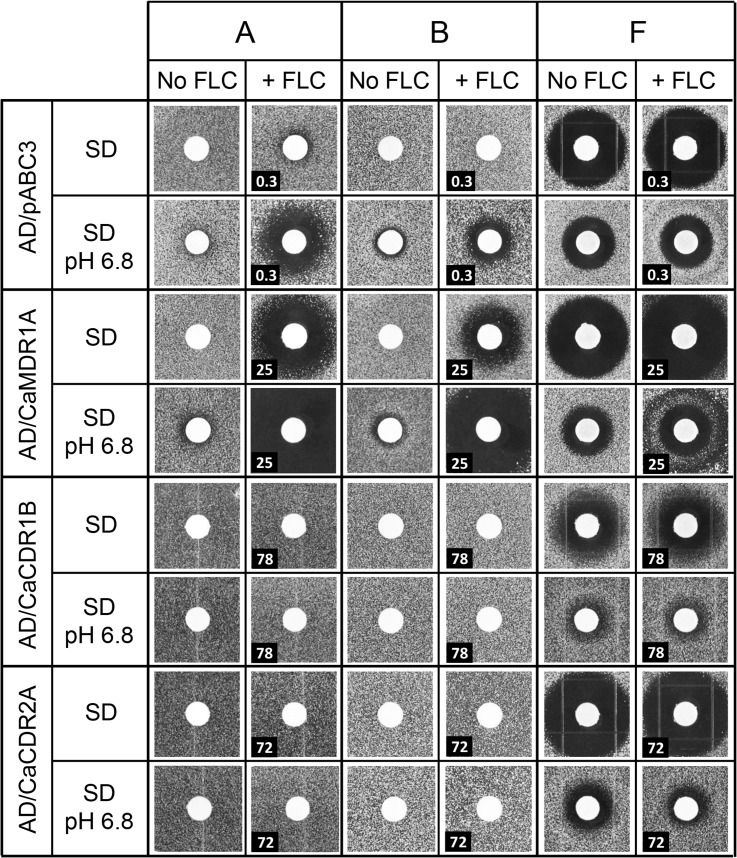
Antifungal and chemosensitization properties of compounds A, B and F tested using strains of S. cerevisiae overexpressing membrane transporters.Each compound was loaded at 50 nmol per disk. The concentration of FLC (μM) in the media (~1/8 MIC for each strain) is shown in the bottom left corner of the relevant panels.